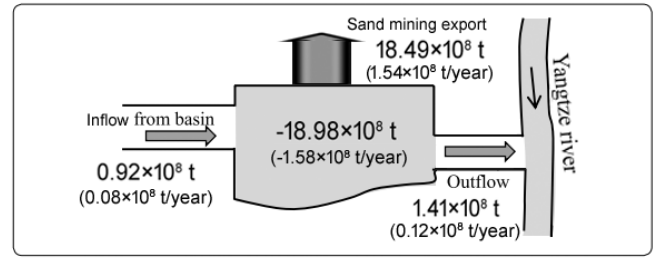
Figure 9. Sediment budget of Poyang Lake during the period 2000–2011.